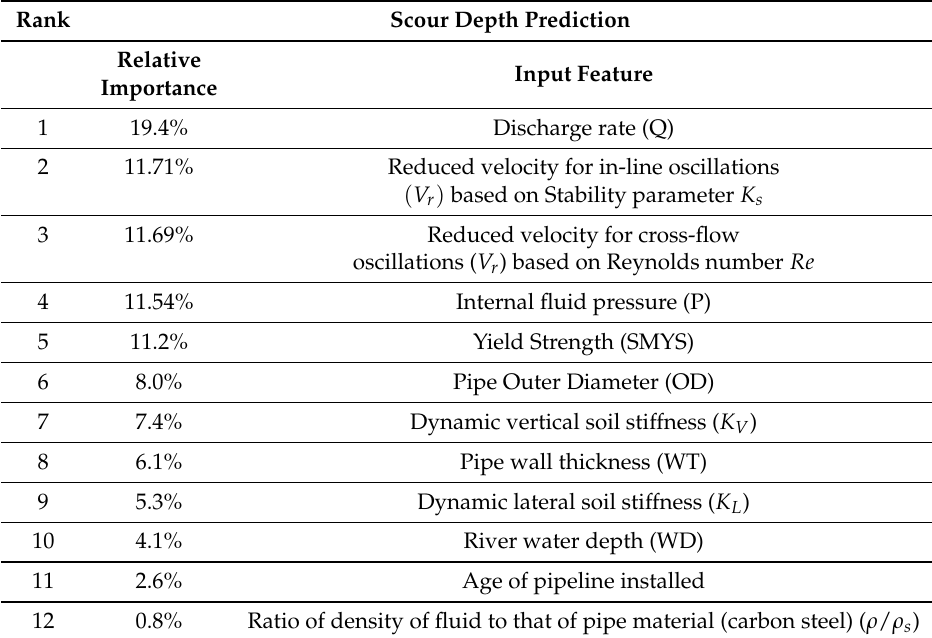
Table 8. Relative importance of input parameters in predicting scour depth.